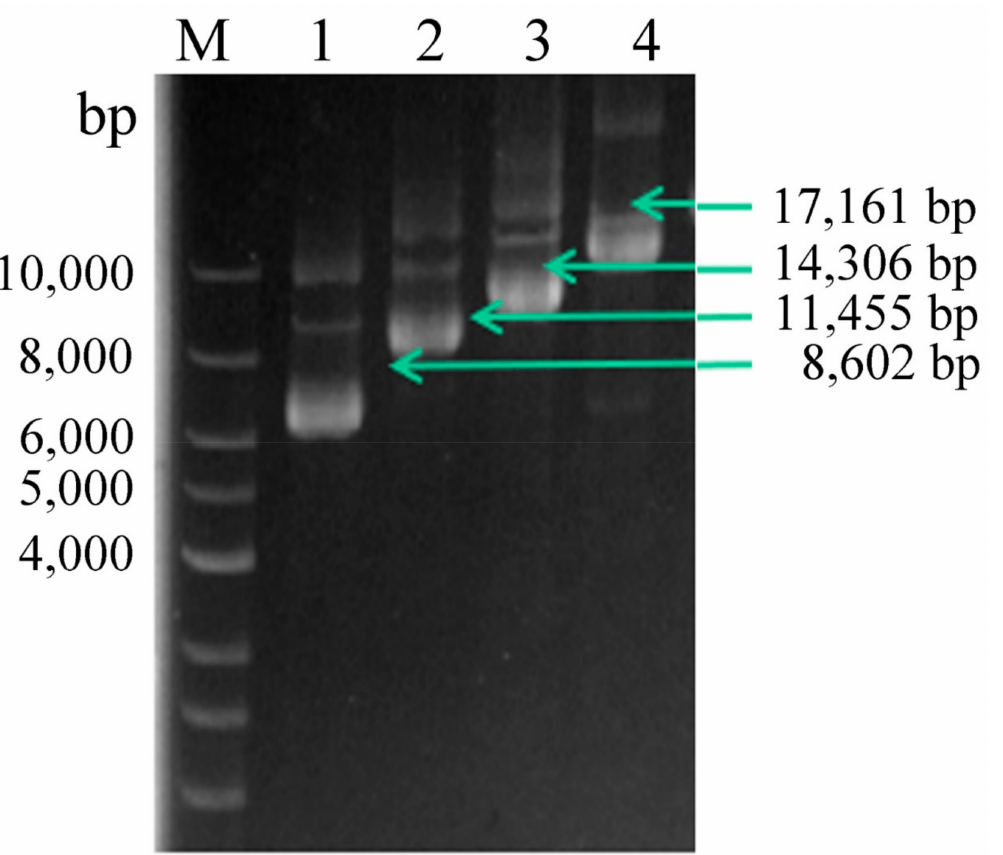
Figure 2. Multi-copy plasmid verification. Lane M, DNA Marker; lane 1, linearized pHBM905BDM- CDA1; lane 2, linearized pHBM905BDM-CDA2; lane 3, linearized pHBM905BDM-CDA3; lane 4, linearized pHBM905BDM-CDA4.